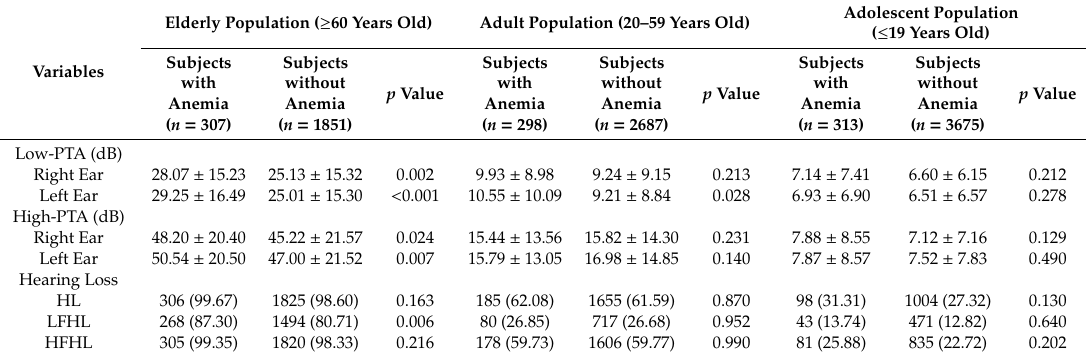
Table 3. High-PTA, low-PTA, and prevalence of hearing loss in subjects with and without anemia according to the age